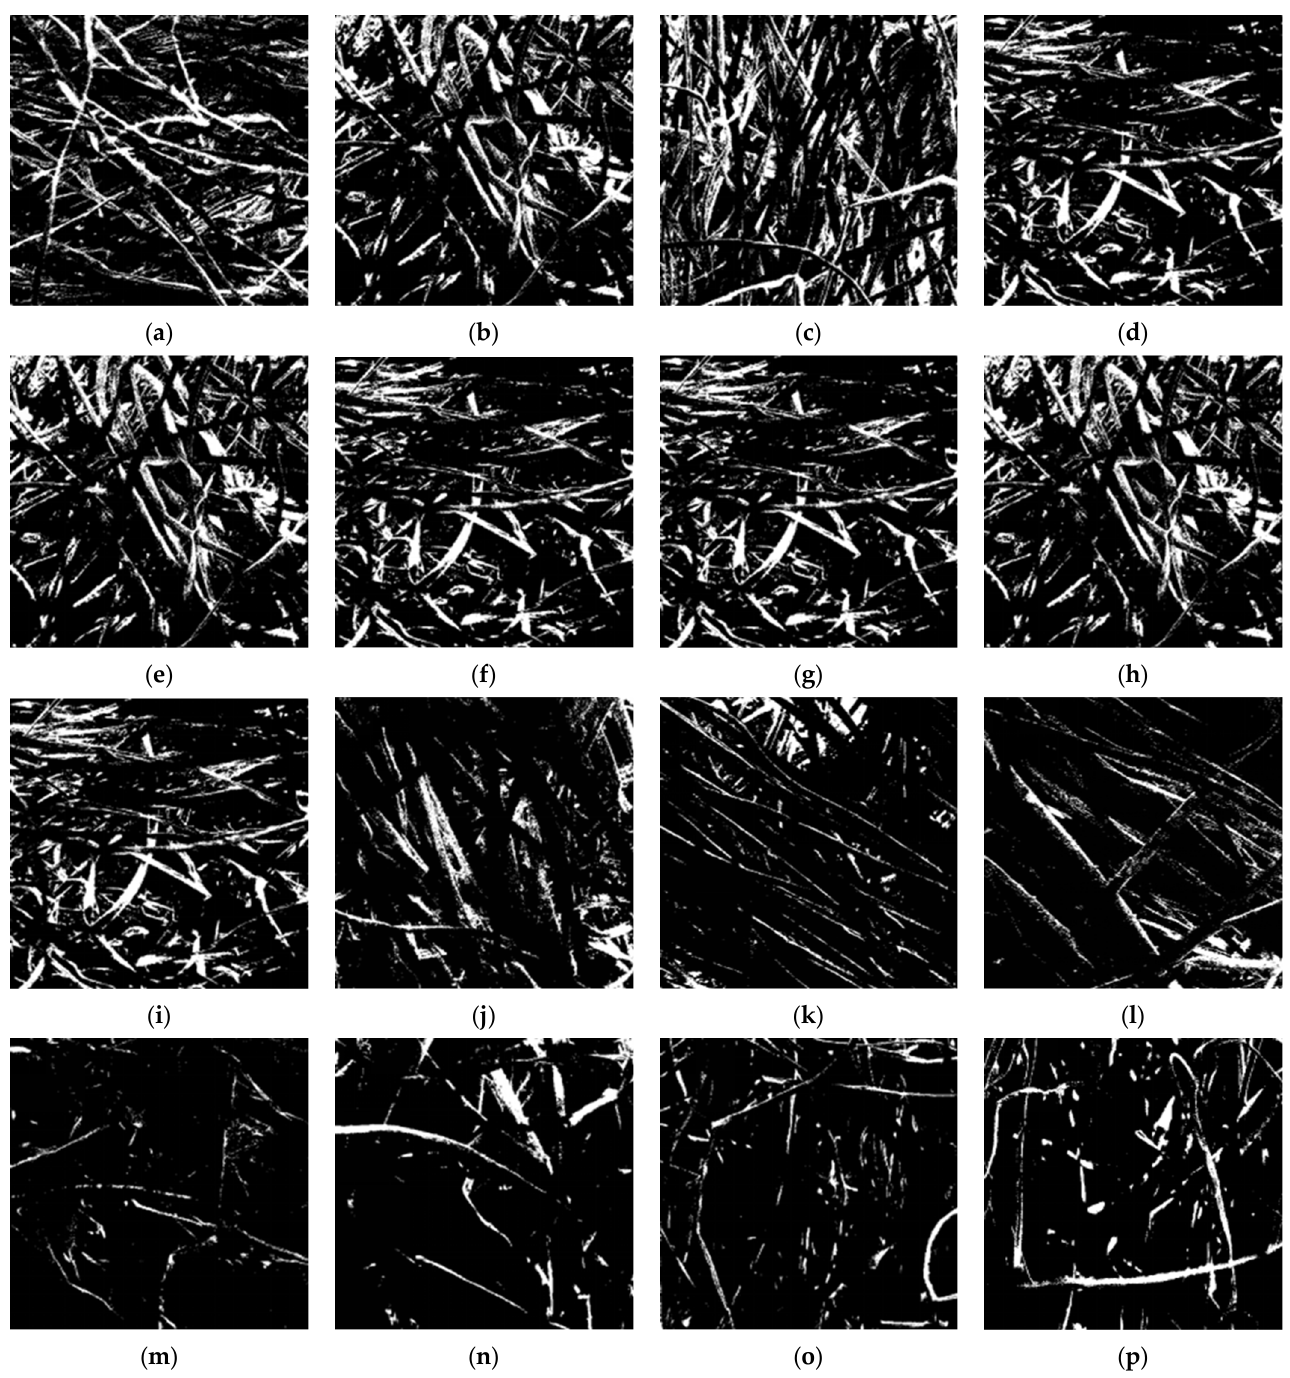
Figure A1. ( a ) Volume density 0.139 g/cm 2 ; ( b ) volume density 0.155 g/cm 2 ; ( c ) volume density 0.172 g/cm 2 ; ( d ) volume density 0.188 g/cm 2 ; ( e ) volume density 0.205 g/cm 2 ; ( f ) volume density 0.211 g/cm 2 ; ( g ) kapok fibre 30%; ( h ) kapok fibre 40%; ( I ) kapok fibre 50%; ( j ) kapok fibre 60%; ( k ) thickness of 5 mm; ( l ) thickness of 1.0 cm; ( m ) thickness of 1.5 cm; ( n ) thickness of 2.0 cm; ( o ) thickness of 2.5 cm; ( p ) thickness of 3.0